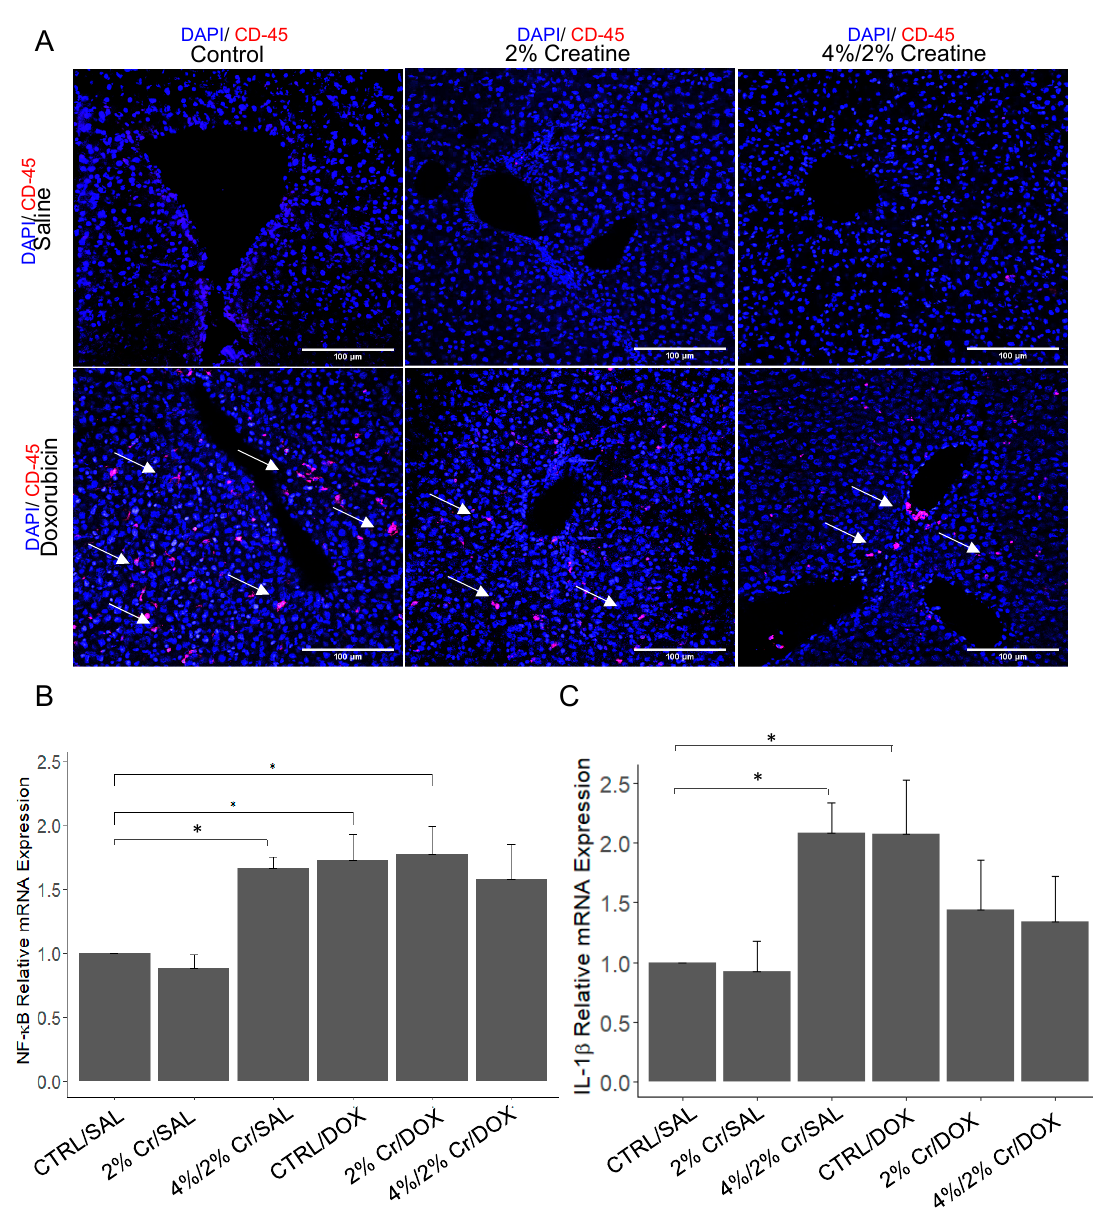
Figure 3. Immunofluorescence staining and mRNA expression of inflammation-related genes. Antibody against CD45 is shown in red and nuclei stained with DAPI are shown in blue. Arrows illustrate positive staining of CD45. ( A ). Positive immunofluorescence staining for CD45 in DOX treated group (bottom row) but not in the control groups (top row) ( A ). mRNA expression of NF- κ B were elevated in CTRL/DOX when compared to CTRL/SAL and no significant decrease was detected in the 2% Cr/DOX or 4%/2% Cr/DOX groups when compared to CTRL/DOX ( B ). mRNA expression of IL-1 β was elevated in CTRL/DOX and 4%/2% Cr/SAL when compared to CTRL/SAL, and a trend toward a reduction in mRNA level was detected in the 2% Cr/DOX or 4%/2% Cr/DOX groups when compared to CTRL/DOX ( C ). The image was obtained under 20 × magnification. Four biological replicates are used in Figure 3B and six biological replicates are used in Figure 3C, and mRNA expression is relative to ACTB. Data is reported as mean ± SE. * p <